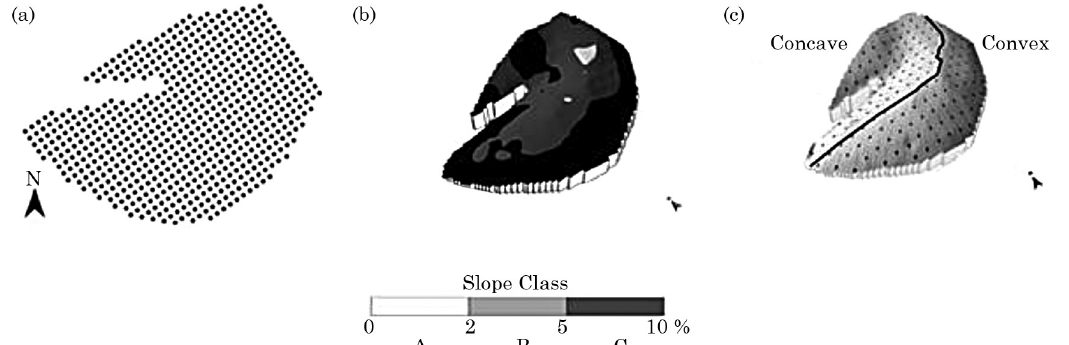
figure 1. Sampling grid (a), digital elevation model and slope class (b), and landforms in the study area